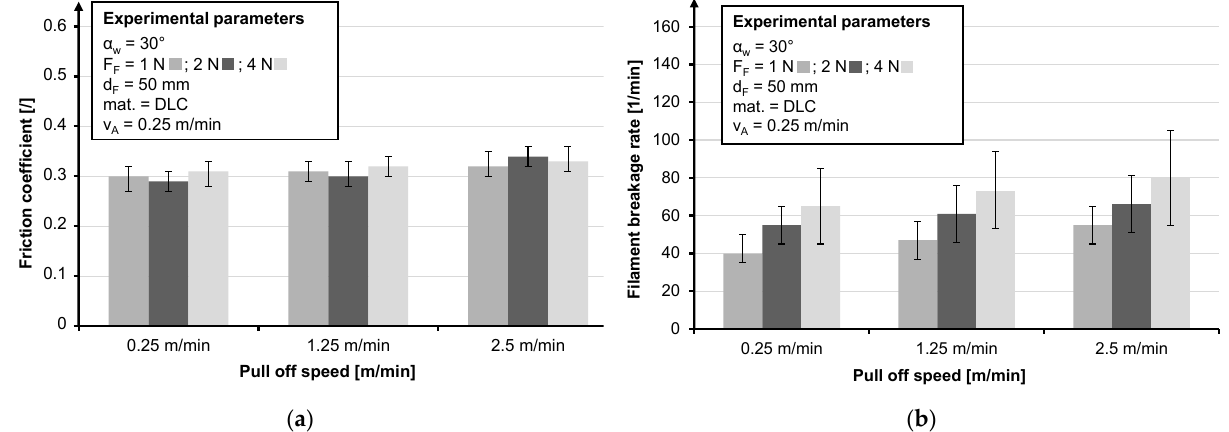
Figure 14. Influence of the pull-off speed and the yarn tension force regarding the friction coefficient ( a ) and influence of the pull-off speed and the yarn tension force regarding the filament breakage rate ( b ).